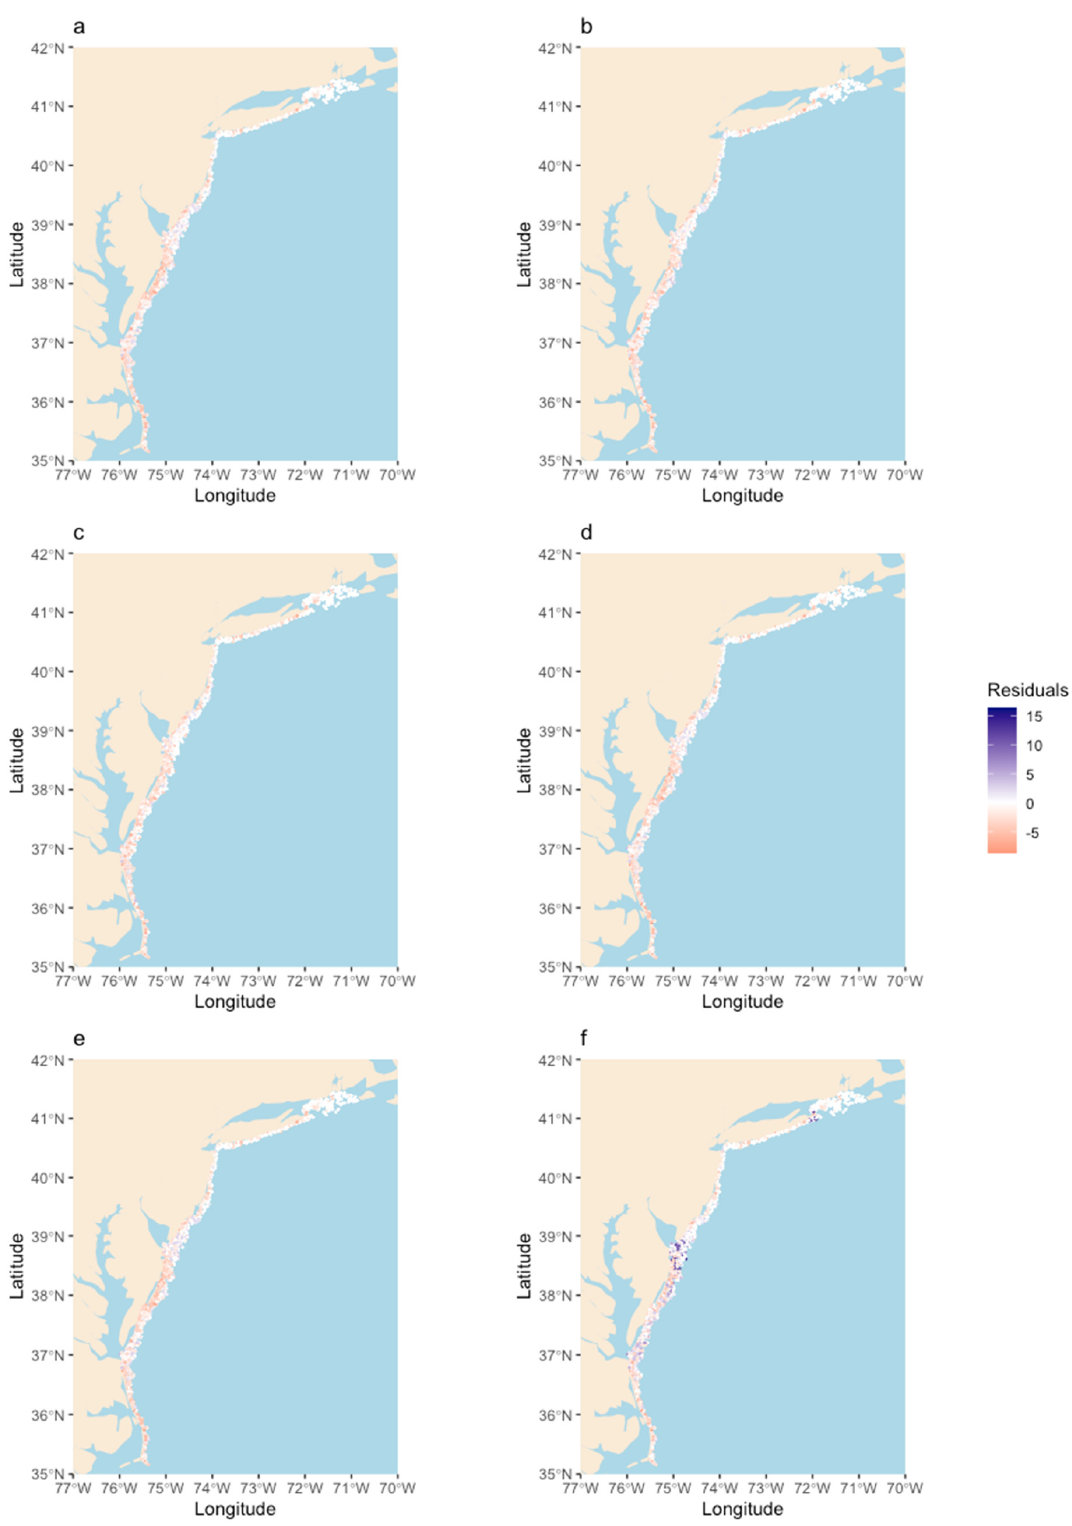
Figure 5. Maps of residuals of six delta models fitted to NEAMAP weakfish survey data. Blue indicates positive, red indicates negative, and color darkness is proportional to the value of residuals (( a ) residuals from delta GLM; ( b ) residuals from delta GAM; ( c ) residuals from delta spatial GAM; ( d ) residuals from delta SAR error model; ( e ) residuals from delta SAR lag model; ( f ) residuals from delta SAR mixed